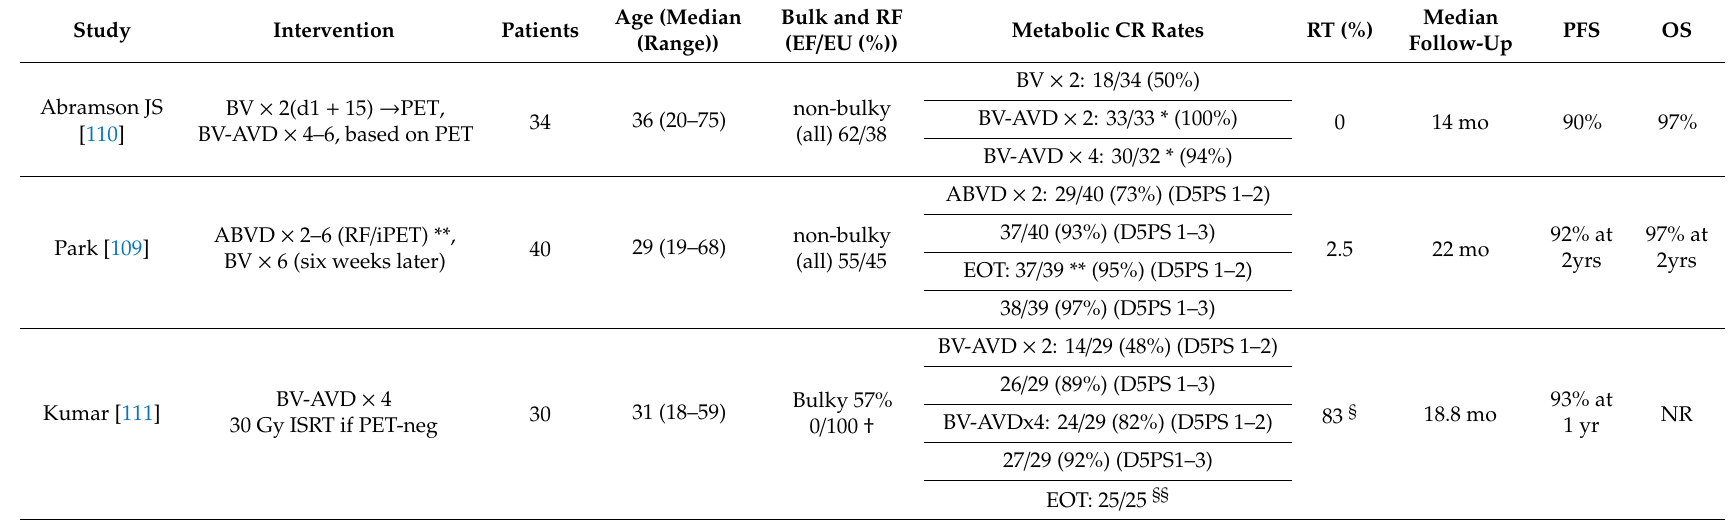
Table 7. Multicenter phase II trials evaluating the combination of brentuximab vedotin with AVD (sequential or concurrent) with or without radiotherapy on limited stage classical Hodgkin